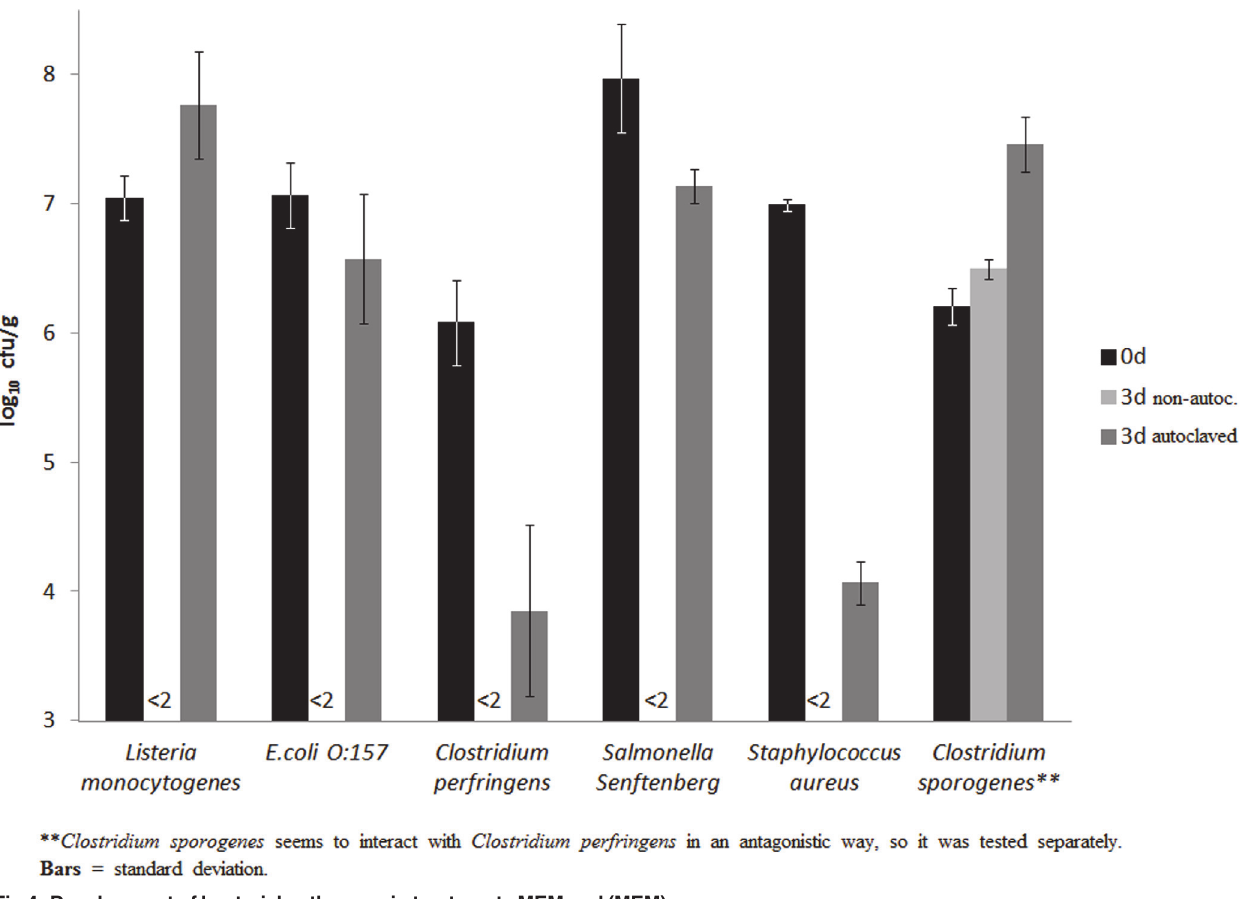
Fig 4. Development of bacterial pathogens in treatments MEM and (MEM) a